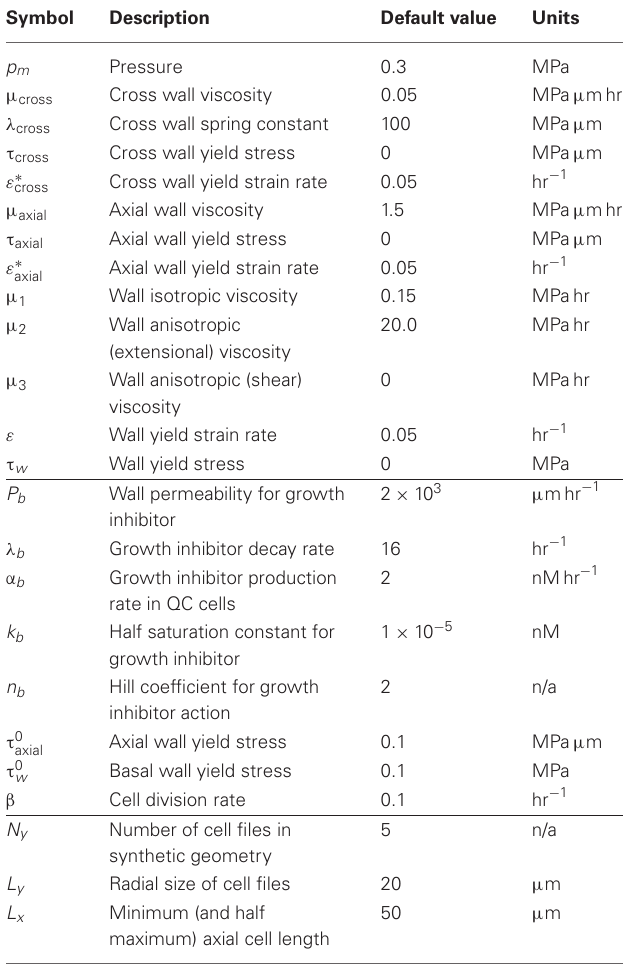
Table 1 | Table of default parameter